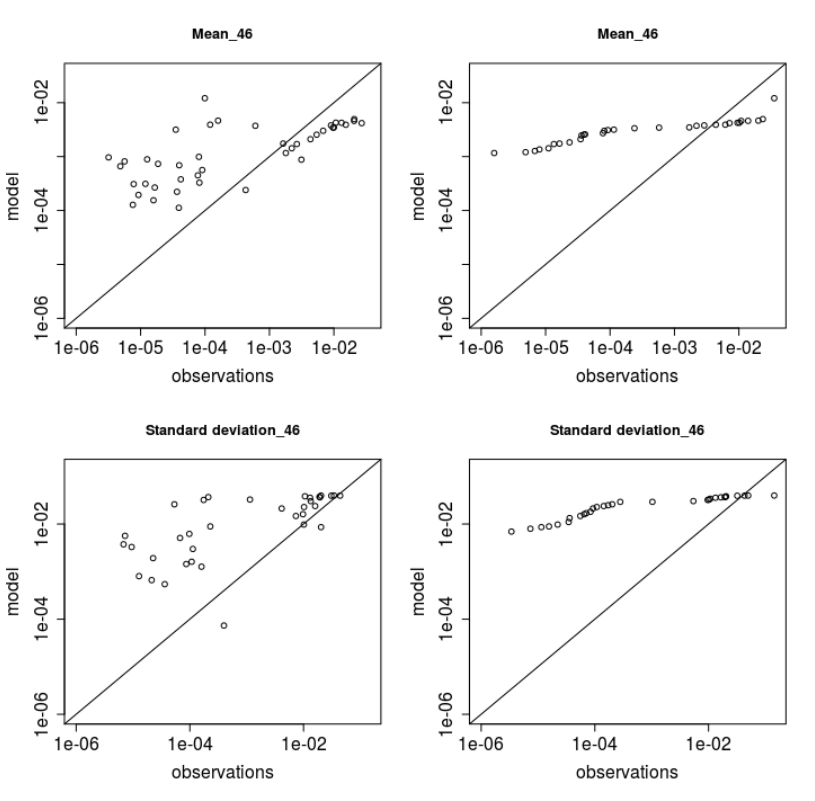
Figure 4. Scatter-plot ( left ) and qq-plot ( right ) for trial 46 (neutral conditions) (g/m − 3